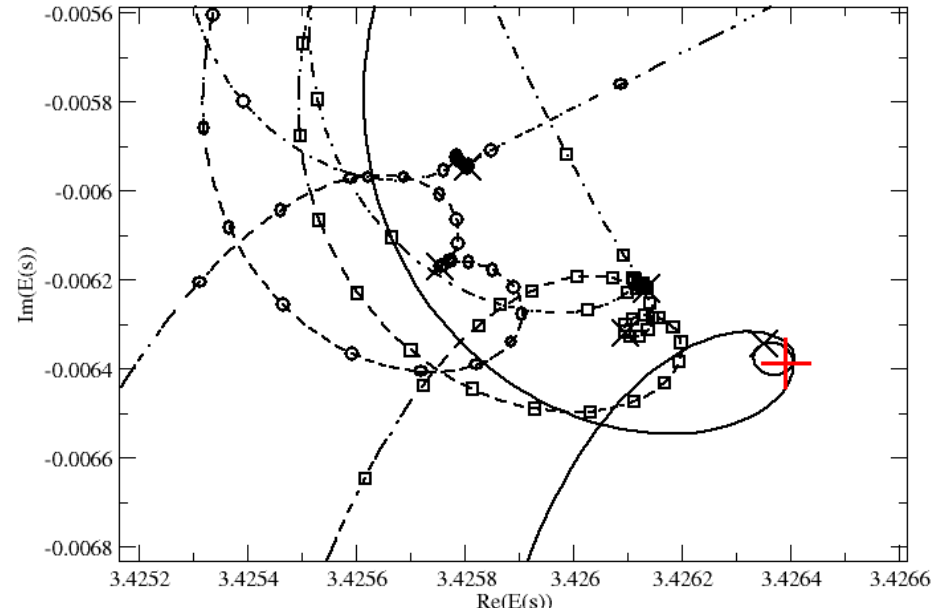
0 z  ) in the case 0.12    for the problem I (solid line), problem II Figure 4. Trajectories (with 0 (dashed lines), and problem III (dash-dotted lines). Calculations were carried out for various values of N, i.e., ○ —N = 100, □—N = 600. Signs + and x indicate the position of the resonance and optimal point, respectively. Data are presented in a.u.